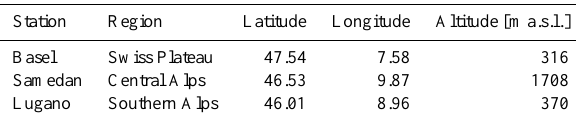
Table 1. Location of the selected in situ snow stations. Station Region Latitude Longitude Altitude [ma.s.l.]